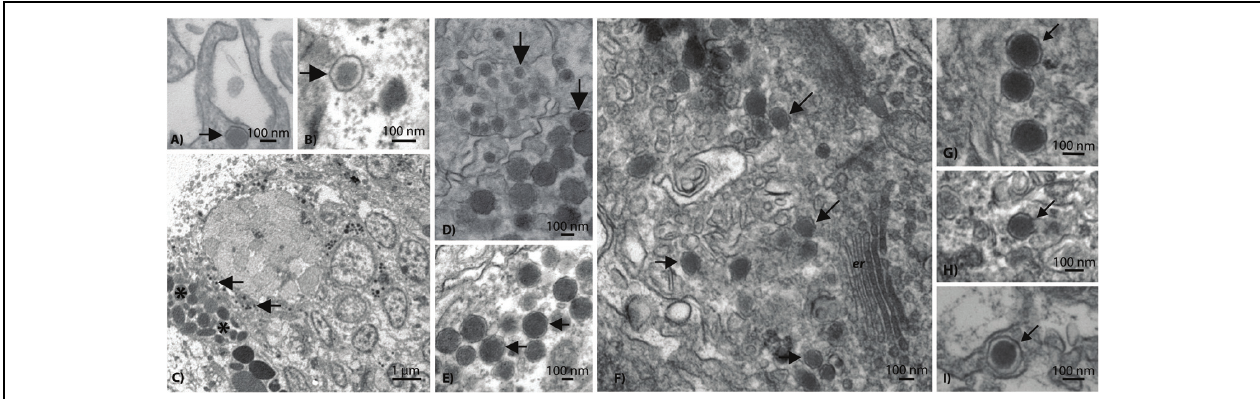
FIGURE 5 | Representative examples of a phycodnavirus-like nucleocytoplasmic large DNA virus (NCLDV) in Acropora aspera (A–E) and Acropora millepora (F–I) coral fragments. Asterisks indicate bacterial cells. Scale bars are as follows: (A,B,D–I) = 100 nm; (C) = 1 µ m.